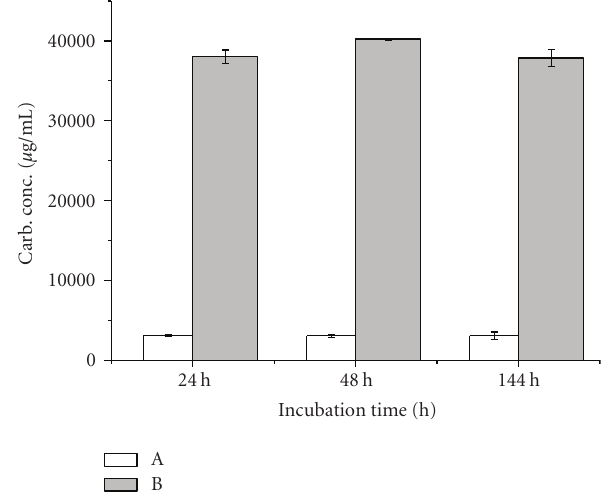
Figure 4: Dubois assay: standard carbohydrate calibration curves • dextran, (cid:2) xanthan, (cid:2) sucrose, and regression lines as linear of fit.